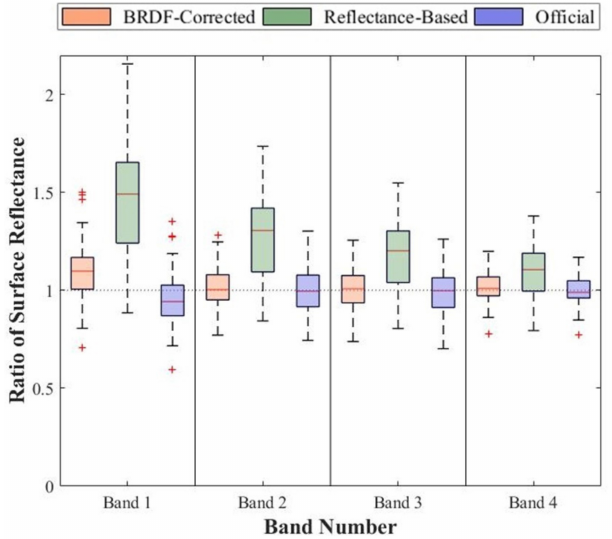
Figure 11. Distributions of the ratio of surface reflectance (MERSI-II/ MYDO9) in the case of the three versions of calibration coefficients derived using different methods. The orange-red, green, and purple boxplots depict the distributions of the ratio between MERSI-II calibrated surface reflectance and MODIS simulated surface reflectance. The central red line in each box plot represents the median value of